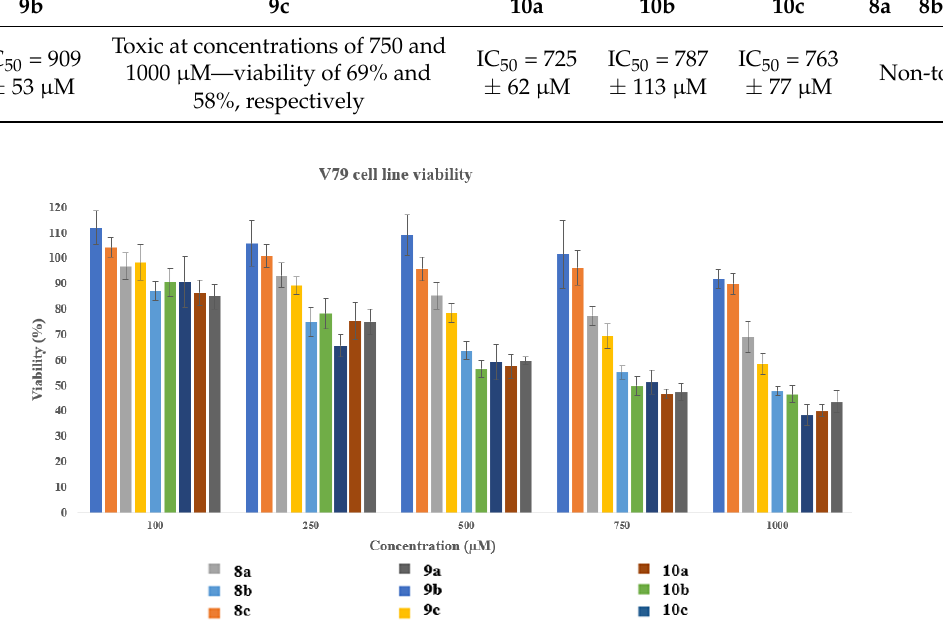
Figure 5. Percentage of cell viability after 24 h incubation with compounds as function of the